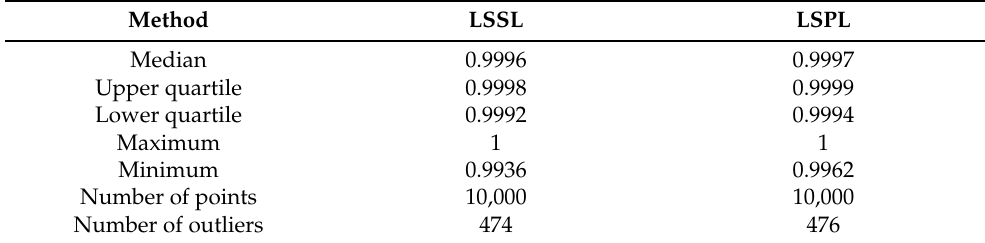
Figure 11. Boxplot of R 2 of LSST and LSPL with Ord = 3 and (cid:101) N = 0.005. Table 2. Distribution of R 2 of LSST and LSPL with Ord = 3 and (cid:101) N =